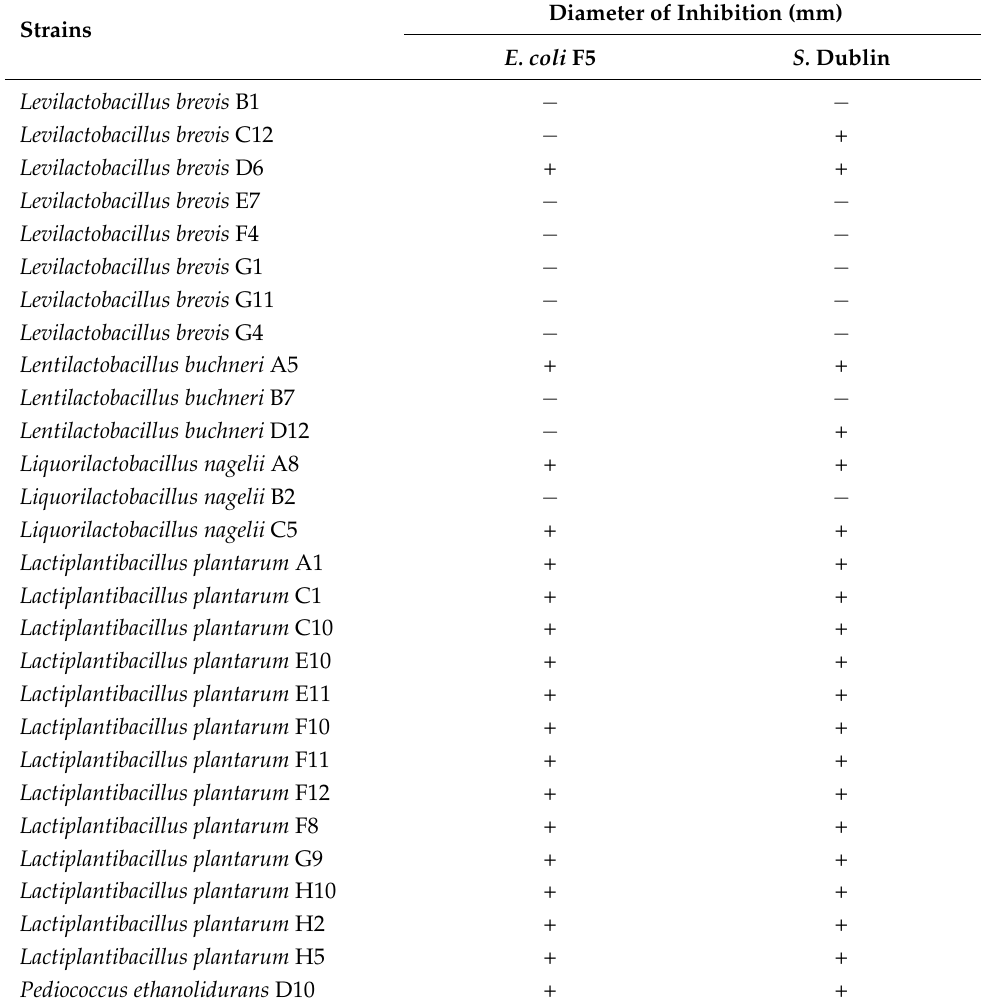
Diameter of Inhibition